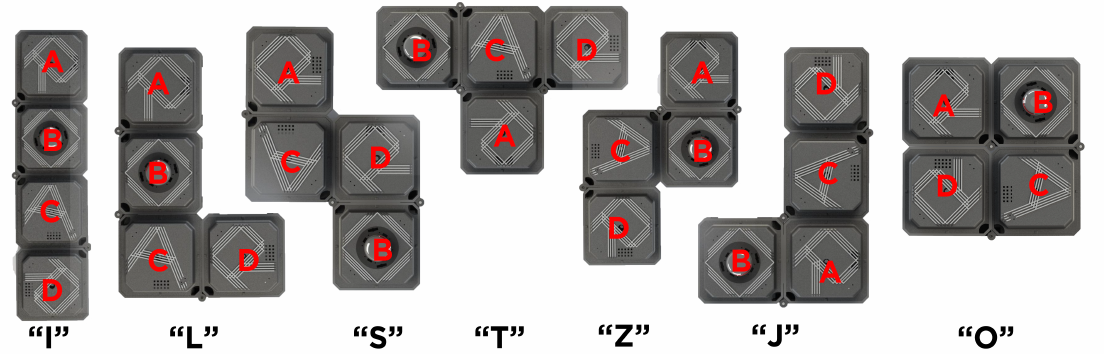
Figure 3. hTetro platform with seven